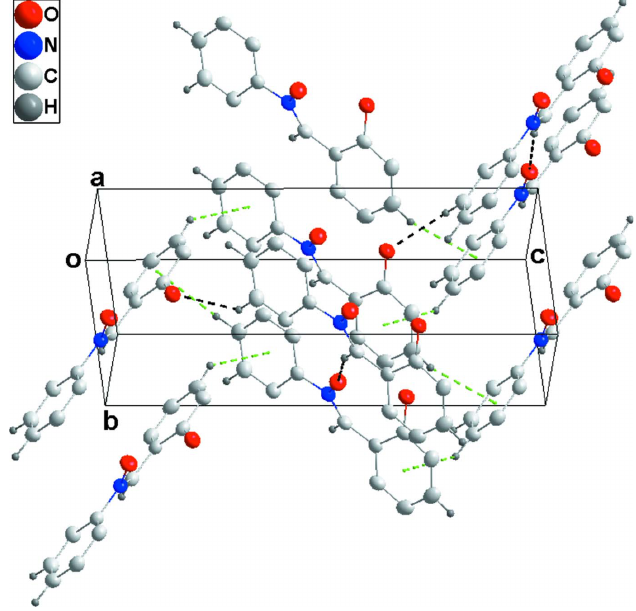
Figure 3 Packing viewed along the (120) direction with intermolecular interactions shown as in Fig. 2.